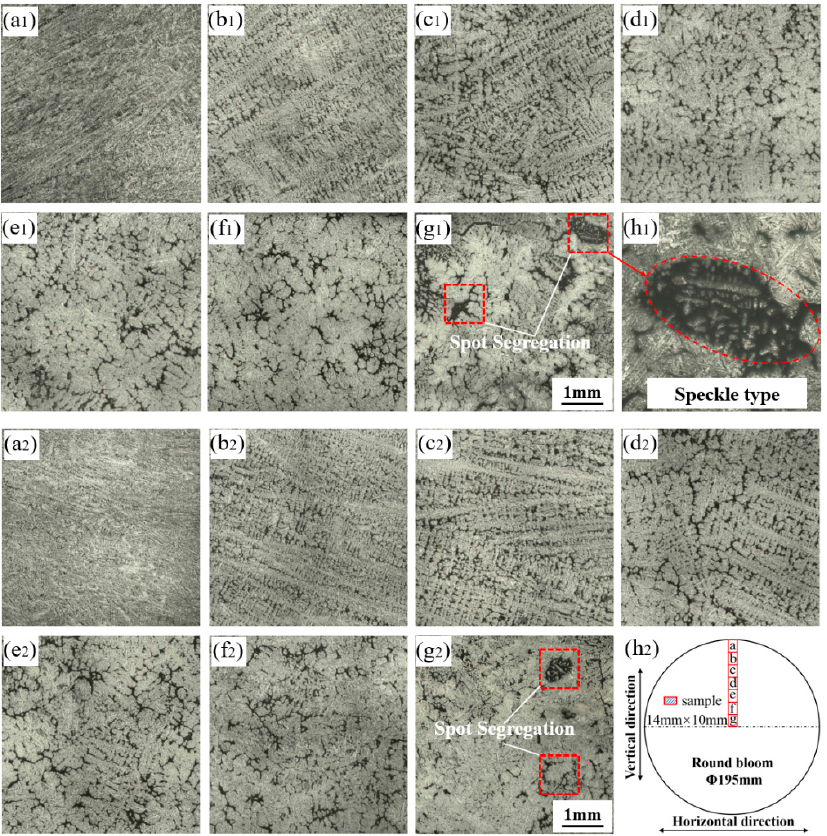
Figure 13. Dendritic morphologies: ( a 1 – h 1 ) are the samples without SR, ( a 2 – g 2 ) are the samples with SR, ( h 2 ) is sampling scheme.